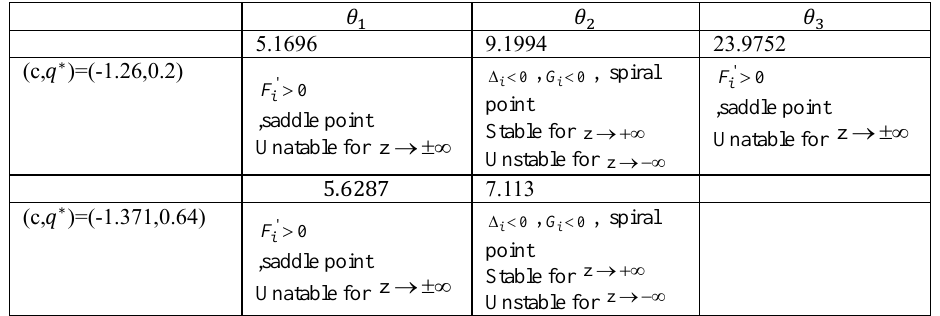
'2 , 2,1i  . i 4 ii FG  𝜃 1 𝜃 2